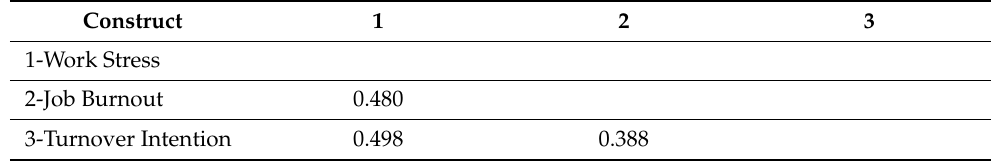
Table 3. Discriminant Validity via